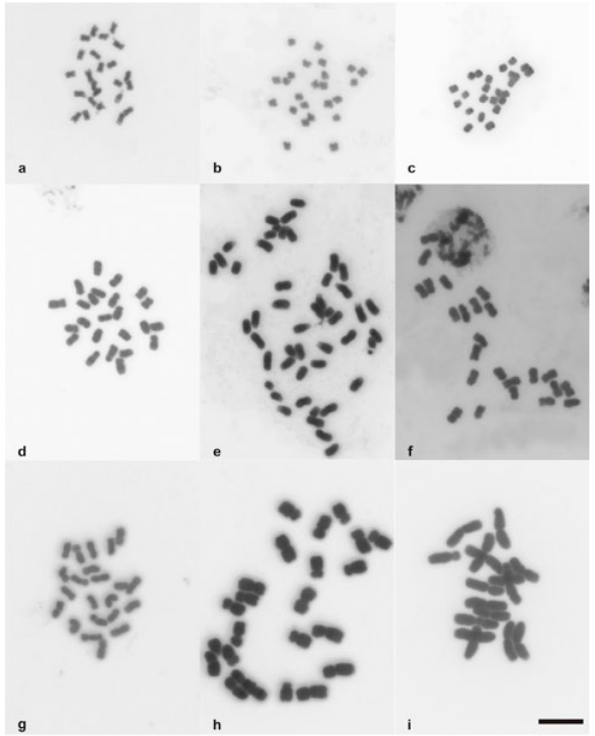
Fig. 1. Somatic metaphases of five genera of Solanaceae. a Solanum flaccidum . b S. adspersum . c S. sanctae-catharinae . d S. inodorum . e Physalis pubescens . f Acnistus arborescens . g Brunfelsia uniflora . h S. diploconos . i Cestrum laevigatum . Bar=10